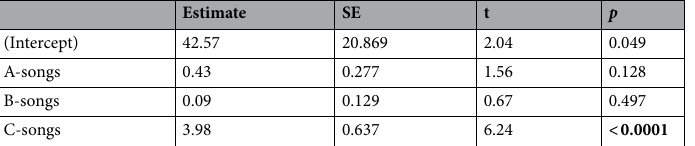
Table 2. A linear regression model explaining the estimated repertoire size of Aquatic Warbler males (the ACE estimator) with the number of A-, B- and C-songs sung by the males (N = 40). Significant values are in